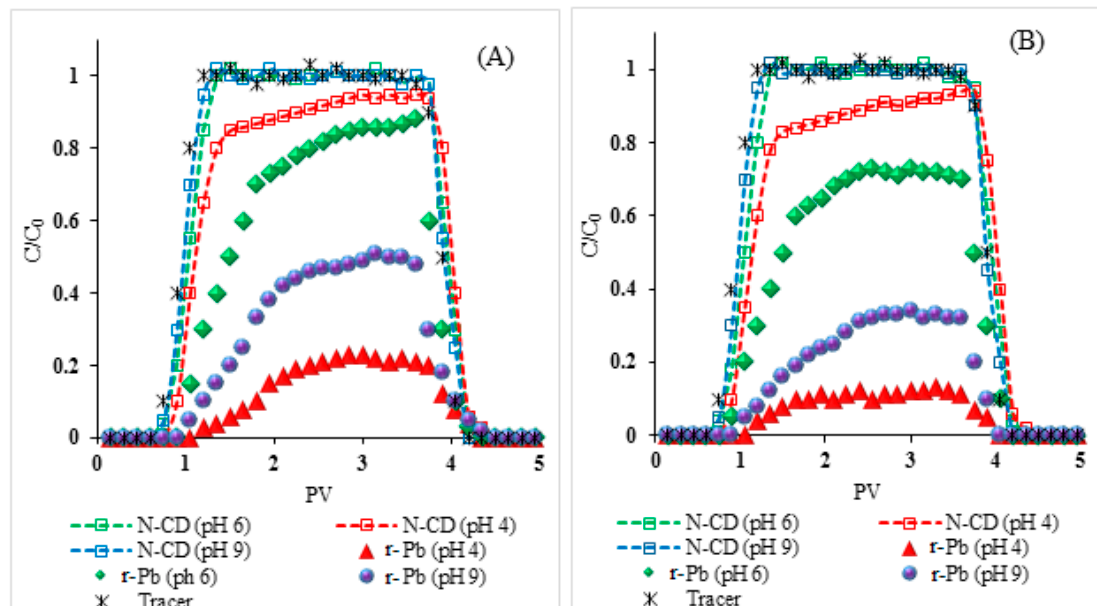
Figure 6. Breakthrough curves (BTCs) of N-CD and released Pb (r-Pb) at different pH. NaCl ( A ), CaCl 2 ( B ). All experiments were performed in C 0 (N-CD / CD): 50 mg · L − 1 , C 0 (Pb): 10 mg · L − 1 , pH6, background solution containing: 1 mM NaCl / CaCl 2 , NaHCO 3 (1 mM), 1 rpm (3.075 mL · min − 1 ) flow rate.